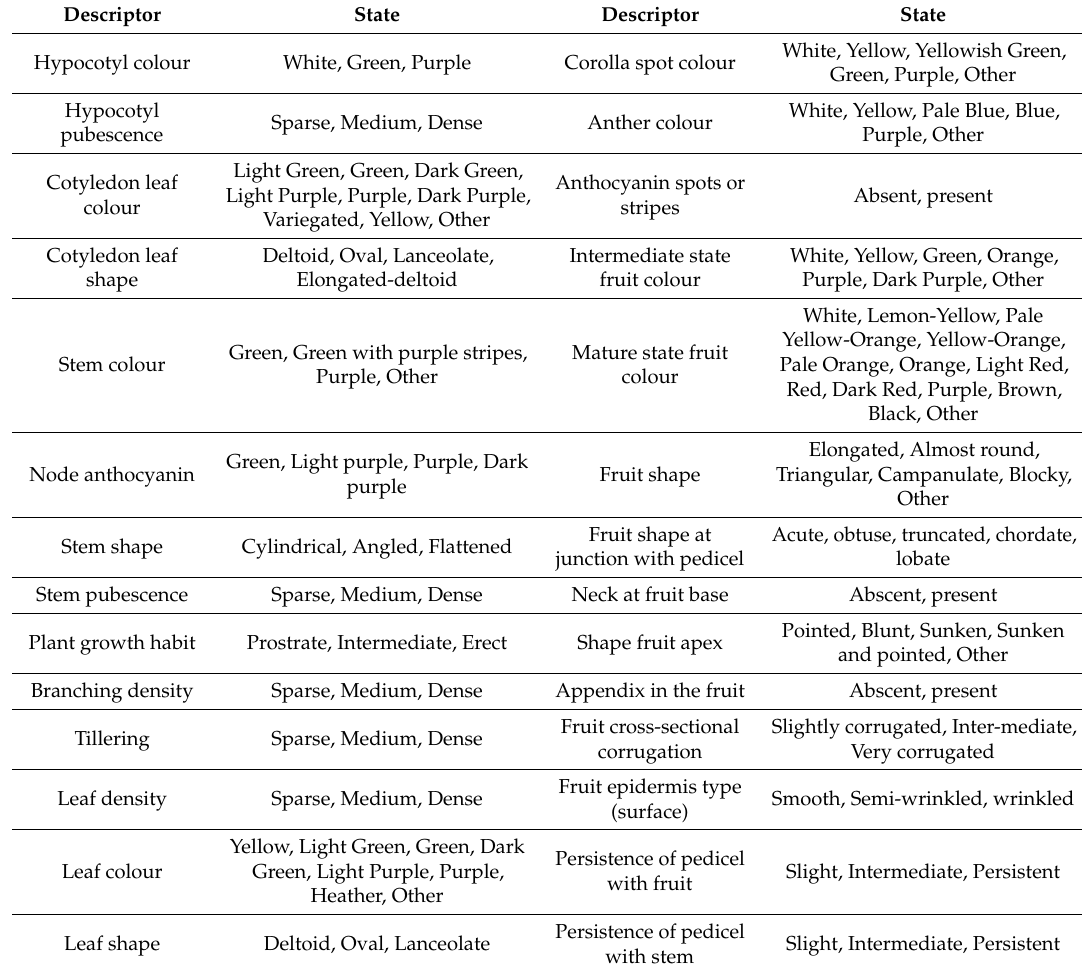
Table 2. Capsicum morphological qualitative